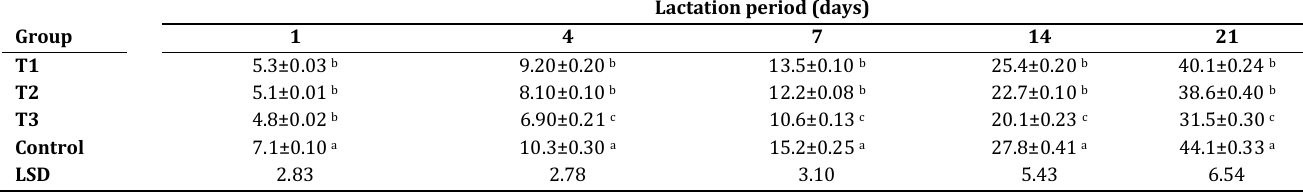
Table 2. Body weight (g) at different lactation periods of newborn pups birthed by Albino Wister female rats treated orally with 0.7 mg/day zinc chloride in different phases of pregnancy